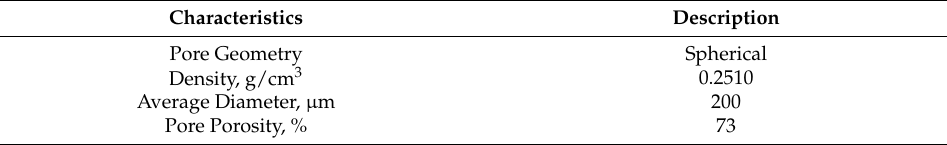
Figure 7. Mesh plot of the simulation model. The electric transient analysis was adopted, considering the impulse voltage in the time domain. One of the electrodes was energized with a standard lightning impulse volt ‐ age with a peak of − 94.5 kV for 100 μ s, which is equivalent to the CFO voltage obtained in the experiment, while another electrode was subjected to 0 kV for the same duration. The energization with CFO voltages shall reflect the maximum stress immediately before the breakdown occurs. The 1.2/50 μ s lightning impulse voltage can be expressed by the dou ‐ ble exponential function as follows [27]: u(t) = u o k( ℮ ‐α t − ℮ ‐β t ), (1) where u o is the peak value of lightning impulse voltage, and α is the attenuation coefficient of the wavefront, which is set to 1.473 × 10 4 . Meanwhile, β is the attenuation coefficient of the wave tail set to 2.08 × 10 6 , and k is the correction coefficient set to 1.043. The whole flow of the simulation study is summarized in Figure 8.